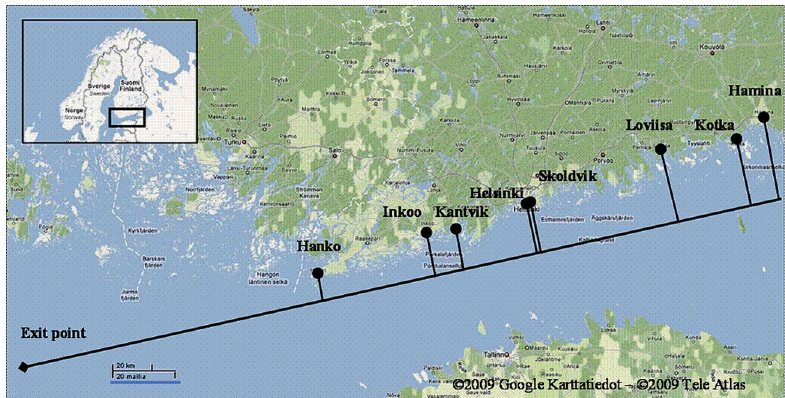
Fig. 1. A map of the Gulf of Finland showing locations of ports included in the study – the estimated route from the harbour through the near coast (first 22.2 km) section and to the open sea Gulf of Finland exit point is also